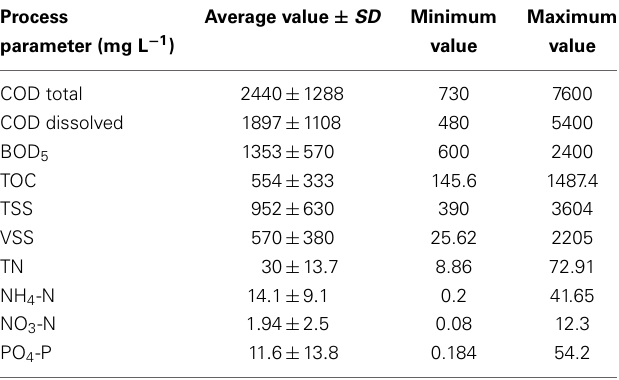
Table 5 | Influent wastewater composition *